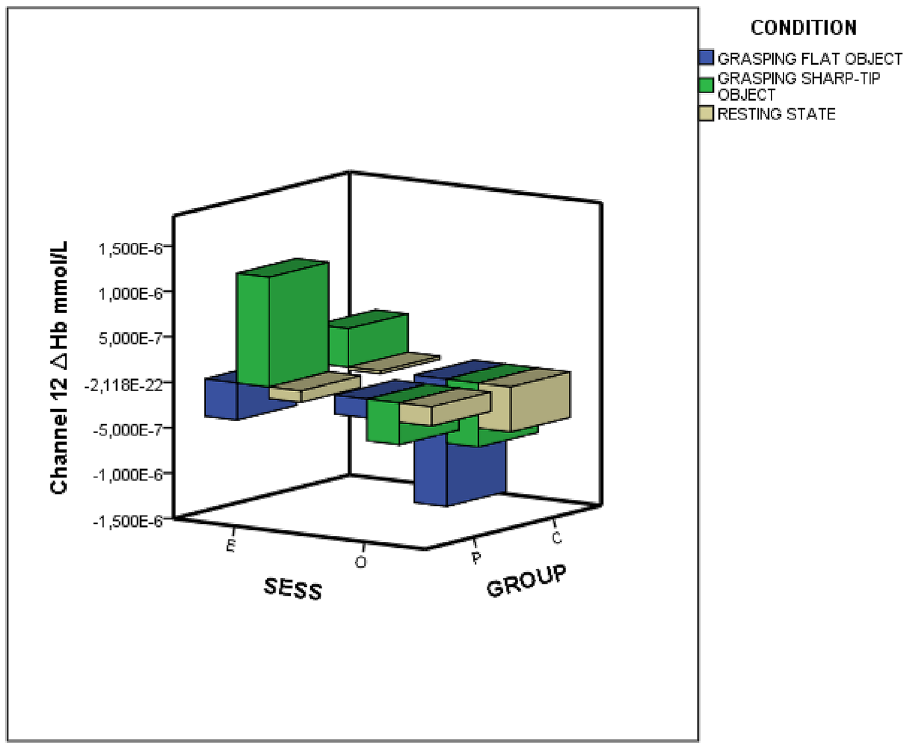
Figure 11. Deoxyhemoglobin levels on an exemplificative channel (channel 12). Sess session, O observation- only session, E time-to-contact detection session, P FM patients, C